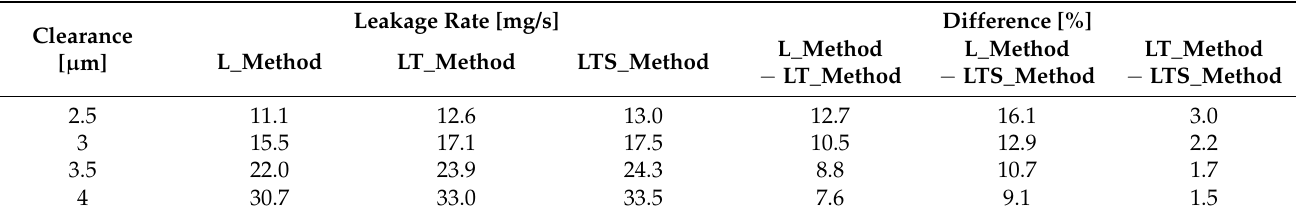
Table 8. Leakage rates according to clearance at an outer pressure of 6